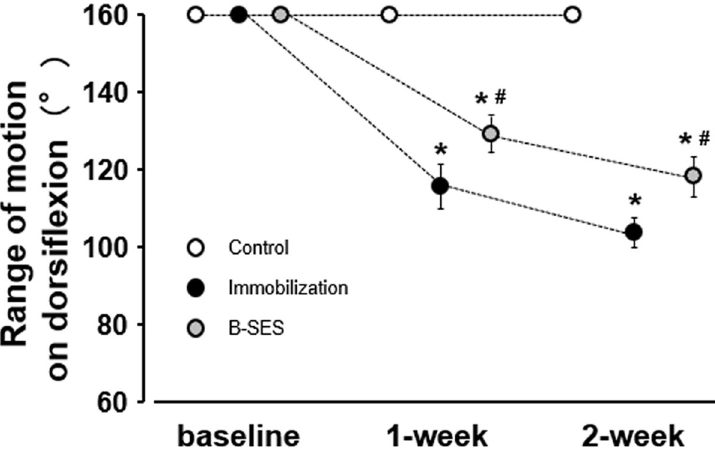
Fig 2. Range of motion of the ankle joint on dorsiflexion. Data presented as mean ± standard deviation. � , Significant difference (p < 0.05) compared with the control group. #, Significant difference (p < 0.05) compared with the immobilization